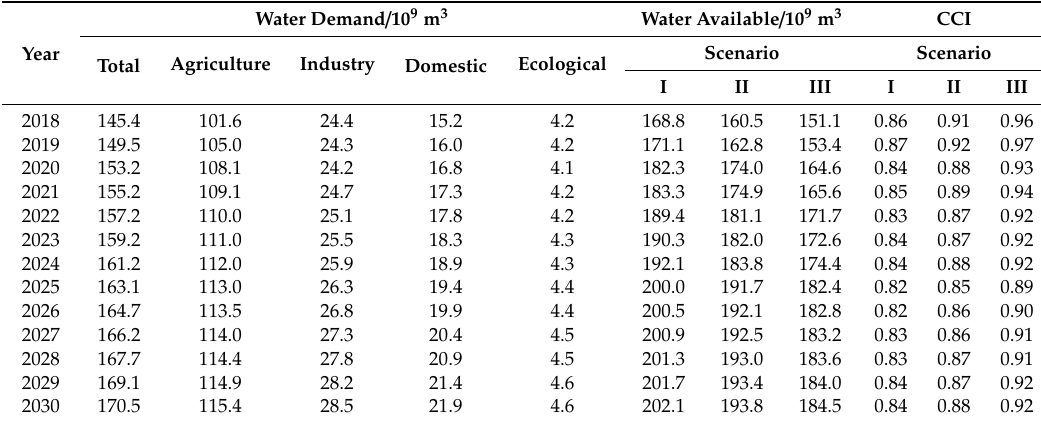
Table 6. Simulation results of water demand / available in Jilin Province from 2018 to